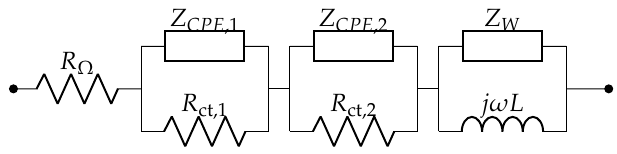
Figure 3. Dhirde model ( N p =